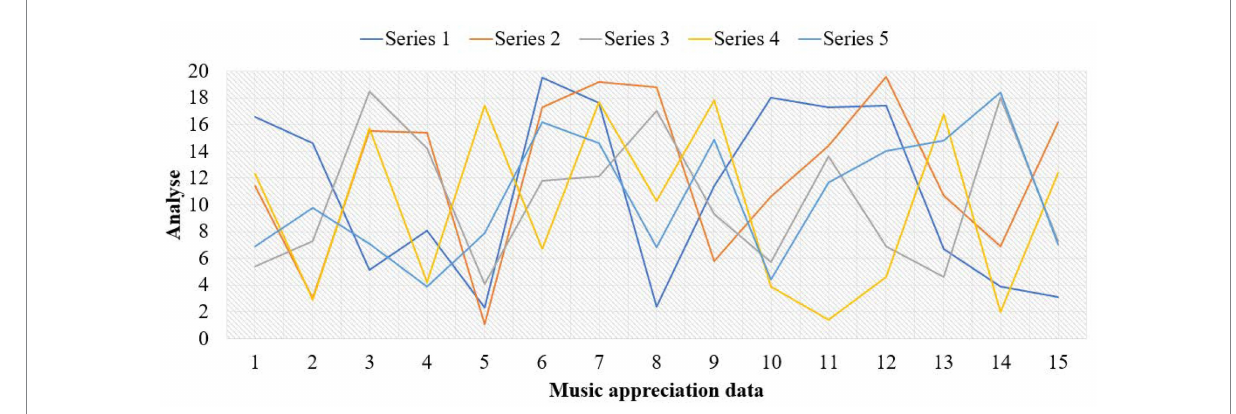
FIGURE 4 Data map of music appreciation influence.